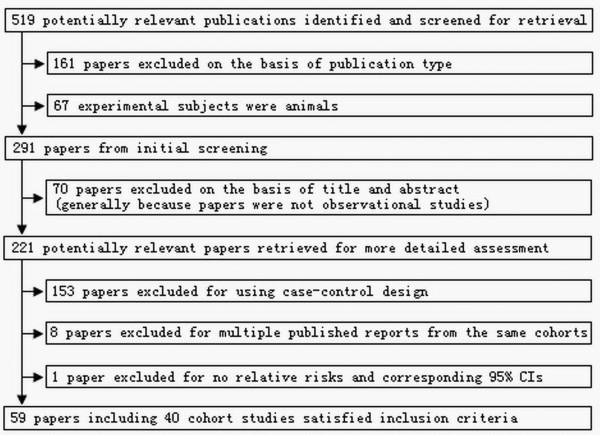
Flow diagram of search strategy and study selection.